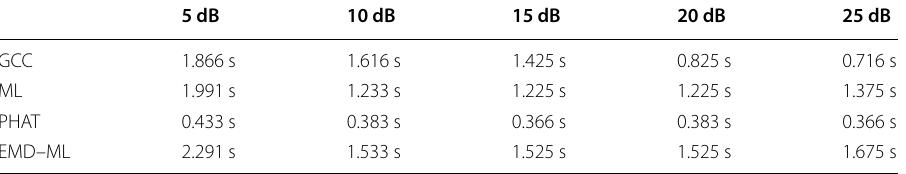
Table 2 Computational efficiency of GCC, PHAT, ML, and